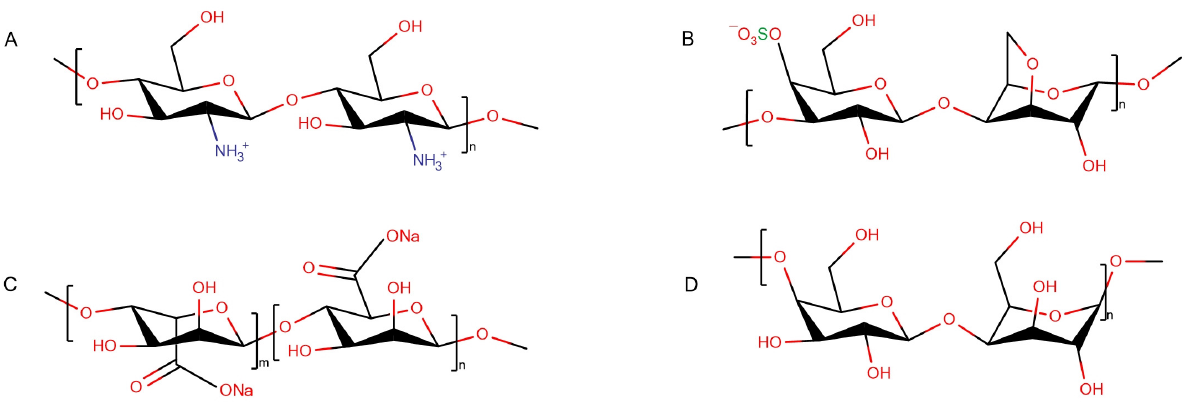
Figure 1. Structural scheme of polysaccharides: chitosan ( A ), κ -carrageenan ( B ), sodium alginate ( C ), β -(1,4)-galactan ( D ).